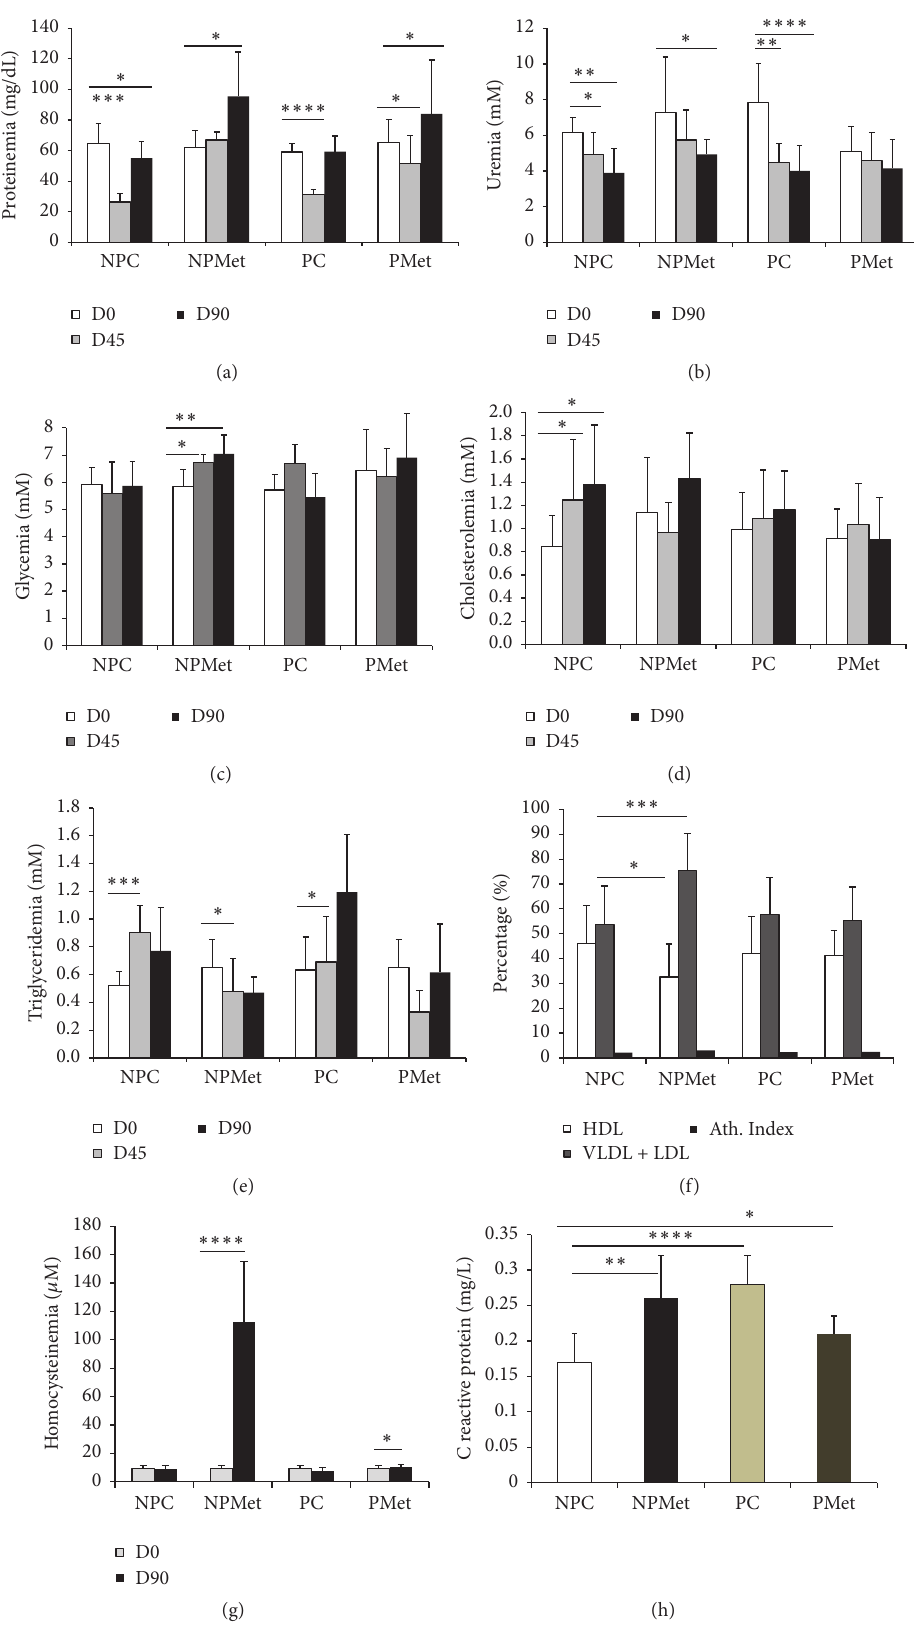
Figure 1: Plasma biochemical parameters of the 4 female rabbit groups. NP: nonpregnant control, NPMet: nonpregnant with Met, PC: pregnantcontrol,andPMet:pregnantwithMet.ComparisonofNPMetversusNPCandPMetversusPC( ∗ 𝑝 < 0.05 , ∗∗ 𝑝 < 0.01 , ∗∗∗ 𝑝 < 0.001 , and ∗∗∗∗ 𝑝 < 0.0001